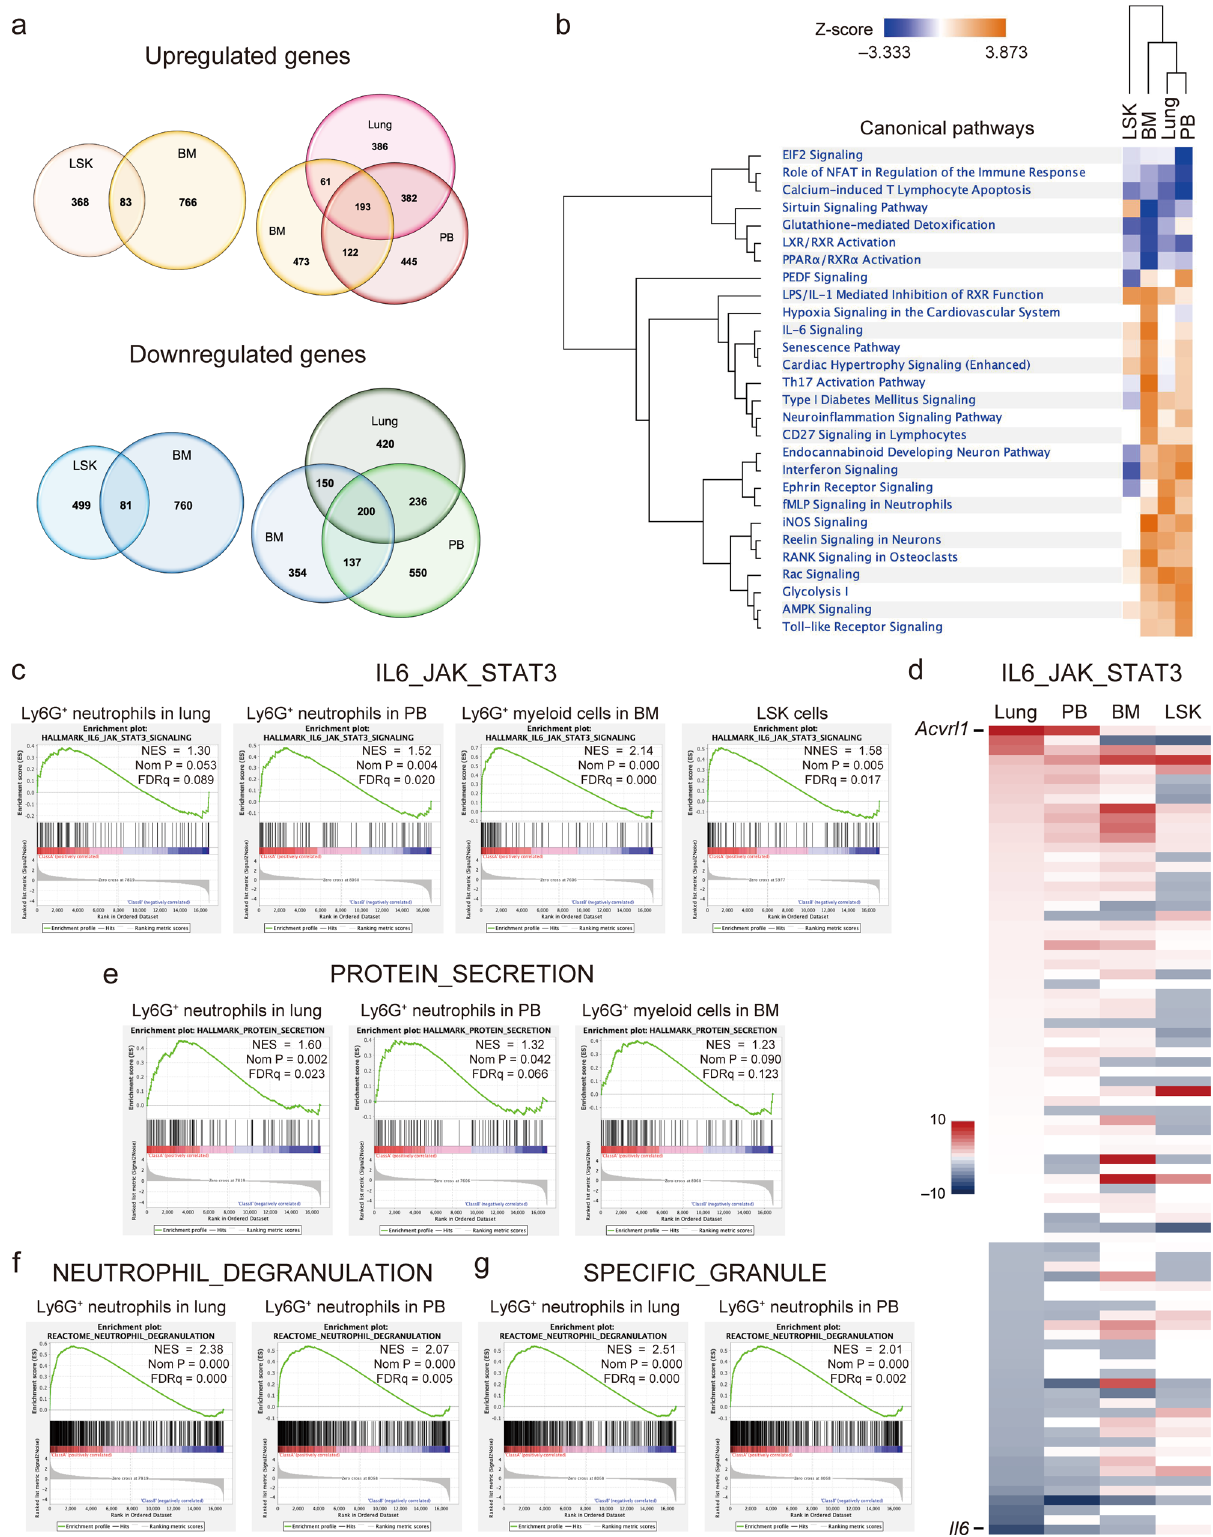
BM. JAK2V617F may increase the adhesion and rolling of neu- trophils partly due to increases in formyl peptide receptor (FPR) 17 , as our RNA sequencing data demonstrated that both Fpr1 and Fpr2 were higher in the Ly6G + lung neutrophils of JAK2 V617F mice (3.1- and 3.8-fold, respectively) than in those of WT mice. Moreover, it is possible that the JAK2